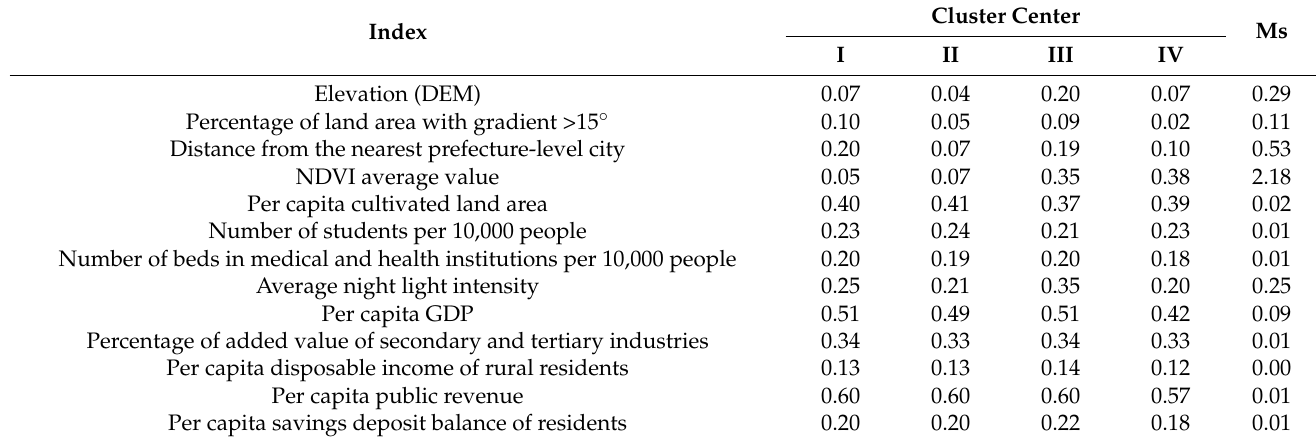
Table 4. Cluster centers and mean